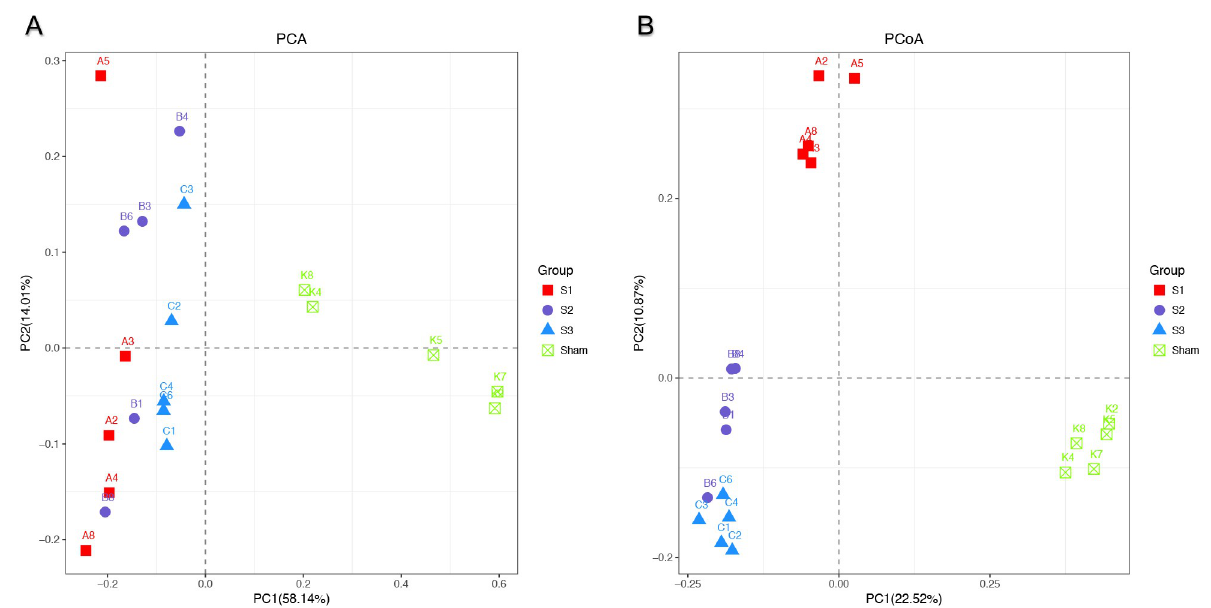
Fig 5. The plots of principal component analysis (PCA) (A) and principal coordinate analysis (PCoA) based on unweighted UniFrac distance metric (B). Samples of rats were presented by different color-filled symbols. Analysis of similarity revealed clustering among rats with obstruction and sham- operated